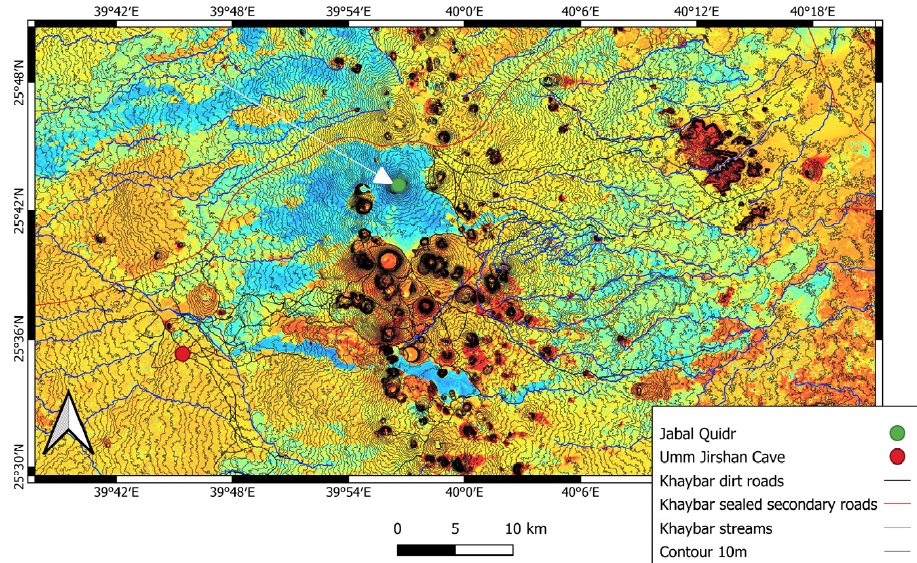
Figure 7. Moisture index map based on a Sentinel image of the center part of the volcanic field. Dark red/orange zones represent low moisture content (e.g., dry ash), while blue regions indicate smooth and moist surfaces, such as young lava flow axes. An arrow points to the location of Jabal Quidr.